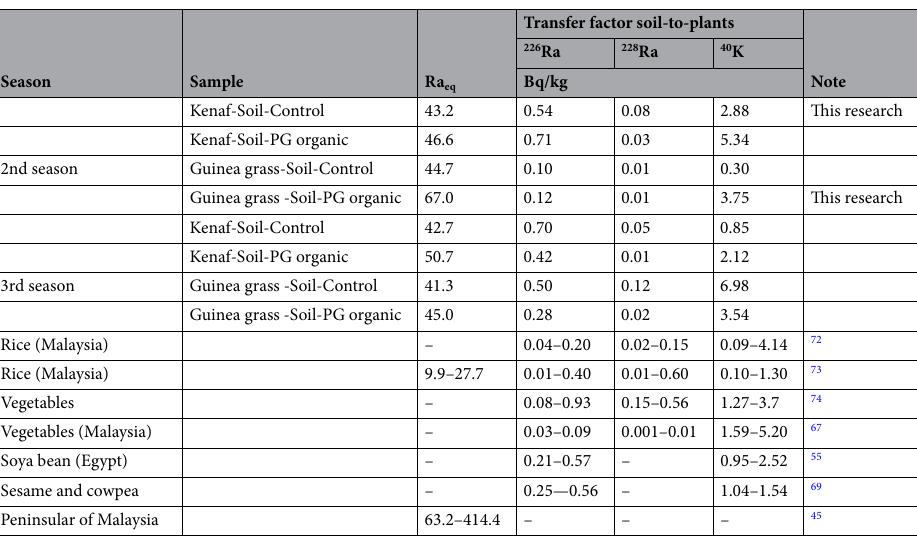
Table 5. Radium equivalent and soil-to-plant transfer factor obtained in this